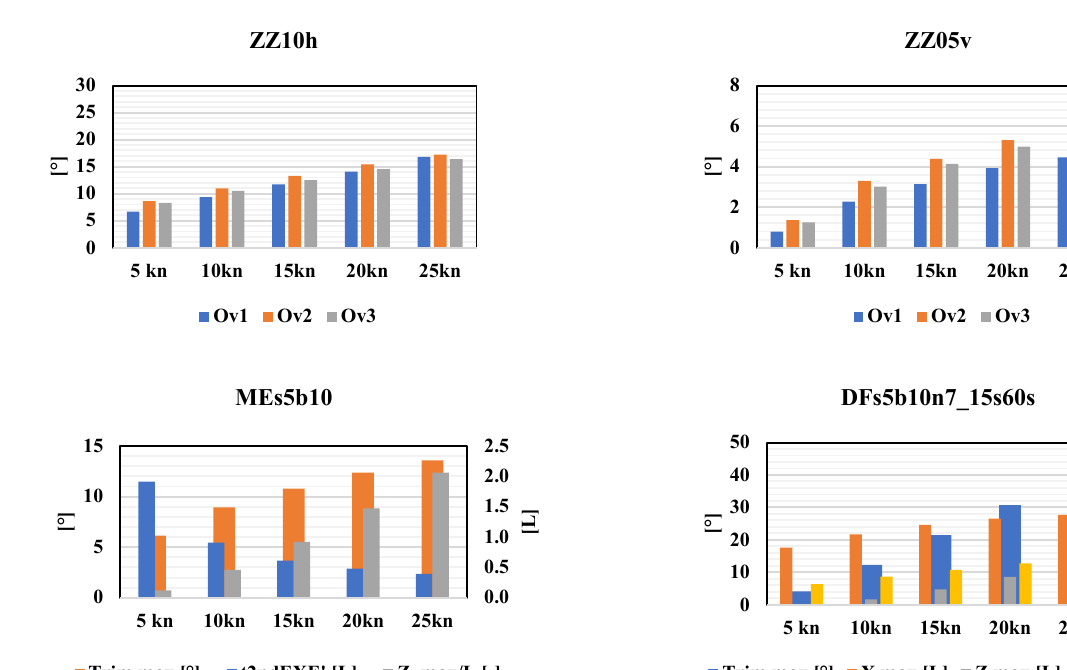
Figure 14. SMG +-Eq—Manoeuvring speed dependency.